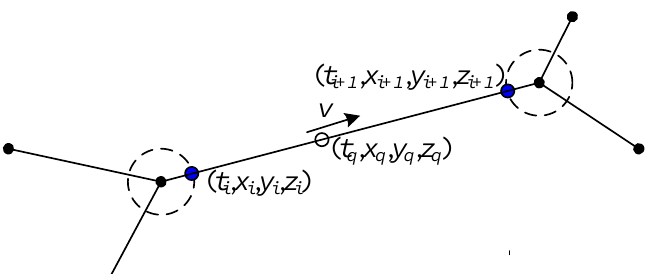
Figure 8. The locations are on the same